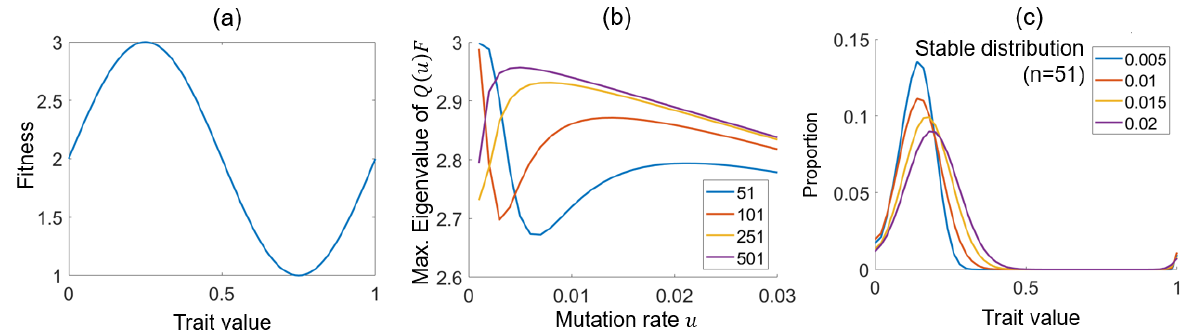
Figure 5. A simple fitness function f ( x ) = sin ( 2 π x ) , shown in ( a ), yields a local optimum near zero. However this moves as the discretization becomes finer, shown as different lines in ( b ), as opposed to the corresponding plots in the previous figures, where only one discretization is used (since these do not change with the number of traits used). Panel ( c ) shows how the stable distributions fail to capture the optimal fitness value, possibly from a bias due to the coarse